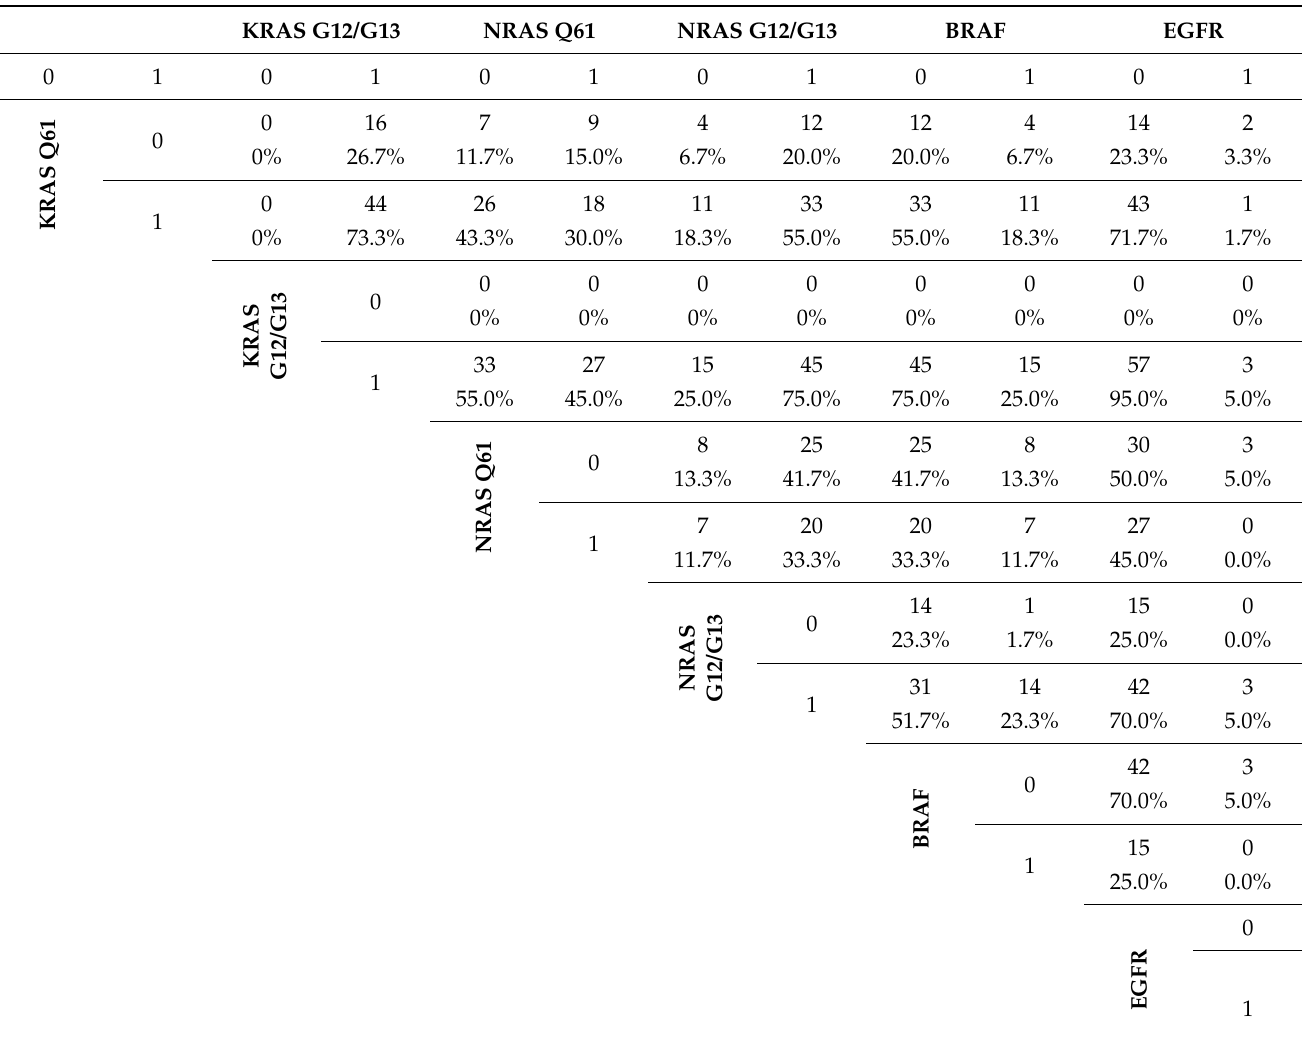
Table 3. The contingency table presents the coexistence of genetic mutations: 0 represents the absence of mutation, and 1 the presence of the mutation ( AF ‰ ≥